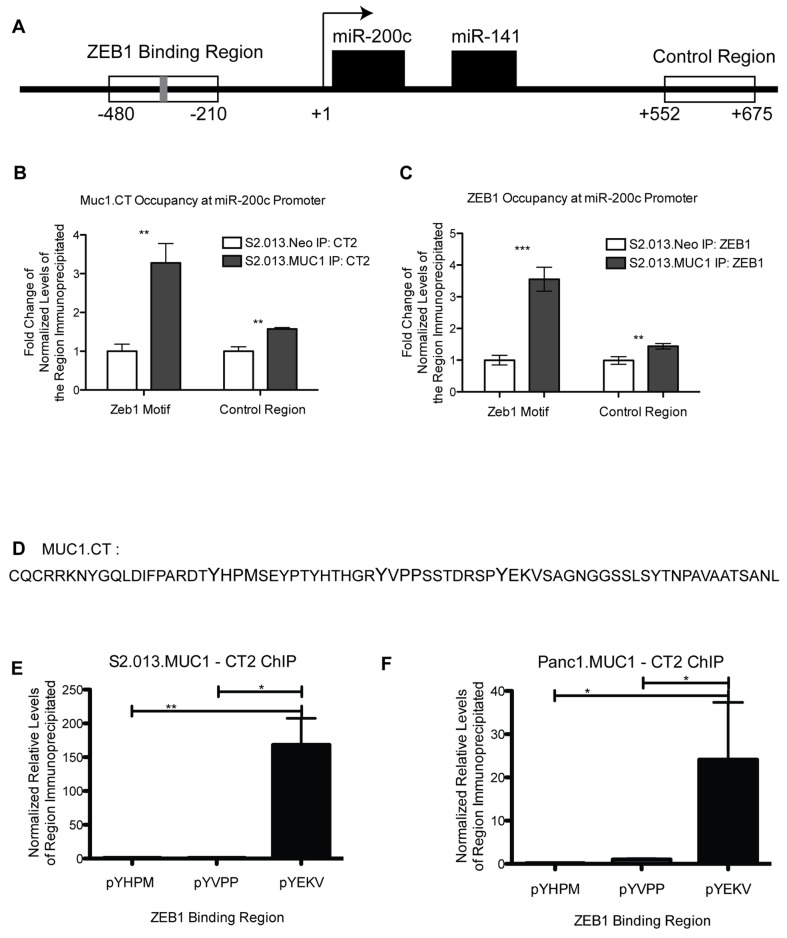
Chromatin Immunoprecipitation confirmation of MUC1.CT and ZEB1 occupancy of the miR-200c/141 promoter.Chromatin immunoprecipitation (ChIP) was utilized to confirm MUC1.CT and ZEB1 occupancy at the miR-200c/141 promoter region. A) Schematic representing the miR-200c/141 promoter region where the ChIP primer sets were designed (-480 to -210, and +552 to +675) and the known ZEB1 binding region (Grey bar). B) ChIP results indicate fold change of normalized relative levels of MUC1.CT occupancy at the ZEB1 binding region (based on qPCR) of the miR-200c/141 promoter in S2.013.MUC1 cells compared to S2.013.Neo cells. C) ChIP results indicate fold change of normalized relative levels of ZEB1 occupancy at the ZEB1 binding region (based on qPCR) of the miR-200c/141 promoter in S2.013.MUC1 cells compared to S2.013.Neo cells. D) Sequence of the MUC1 cytoplasmic tail, indicating three phosphorylated tyrosine motifs that were examined here. E-F) ChIP results indicate relative levels (based on qPCR and normalized to IgG control) of phospho-YHPM, -YVPP, and -YEKV MUC1 cytoplasmic tail at the ZEB1 binding region of miR-200c/141 in the S2.013.MUC1 cells, E, and Panc1.MUC1 cells, F. In both cell lines, only the phospho-YEKV form of MUC1.CT shows significant enrichment at the promoter. All ChIP data was normalized to antibody specific IgG control. (Student’s t-test: *** p < 0.0005, ** p < 0.005, * p< 0.05).